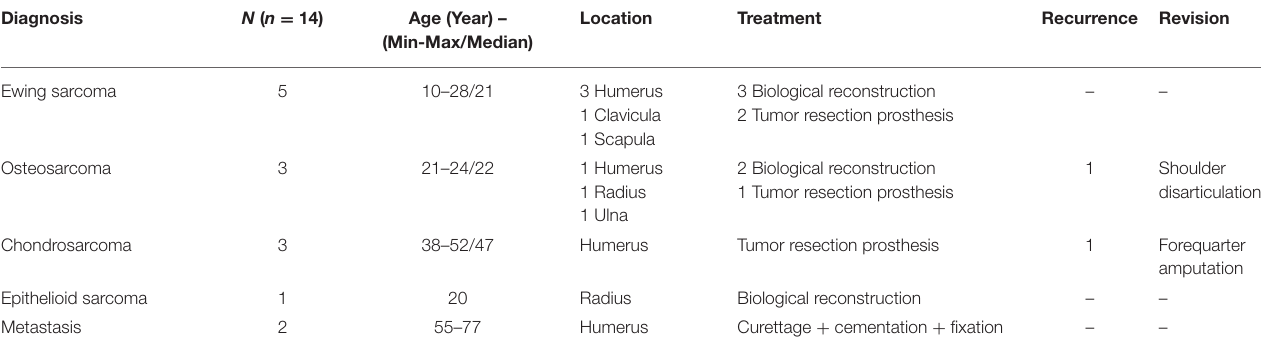
TABLE 5 | Malignant bone tumors of the upper